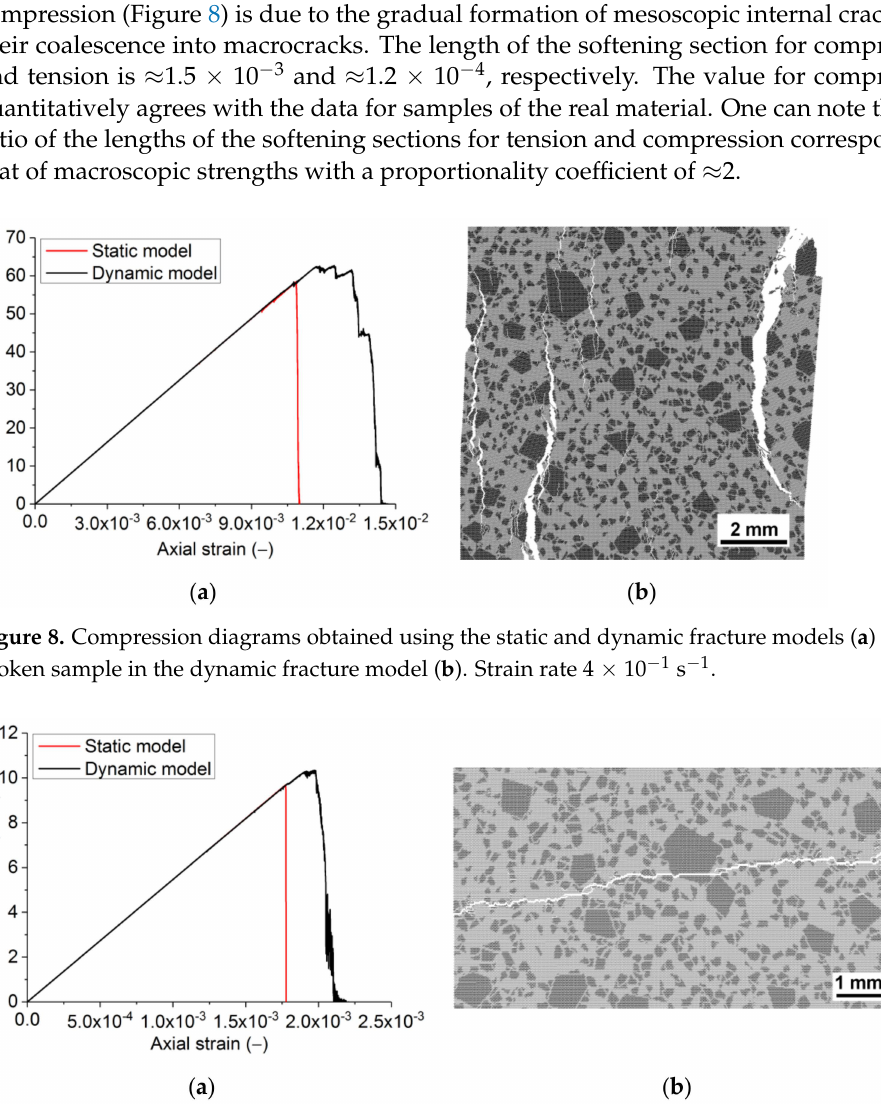
Figure 9. Uniaxial tension diagrams obtained using the static and dynamic fracture models ( a ) and the broken sample in the dynamic fracture model ( b ). Strain rate 2.5 × 10 − 1 s − 1